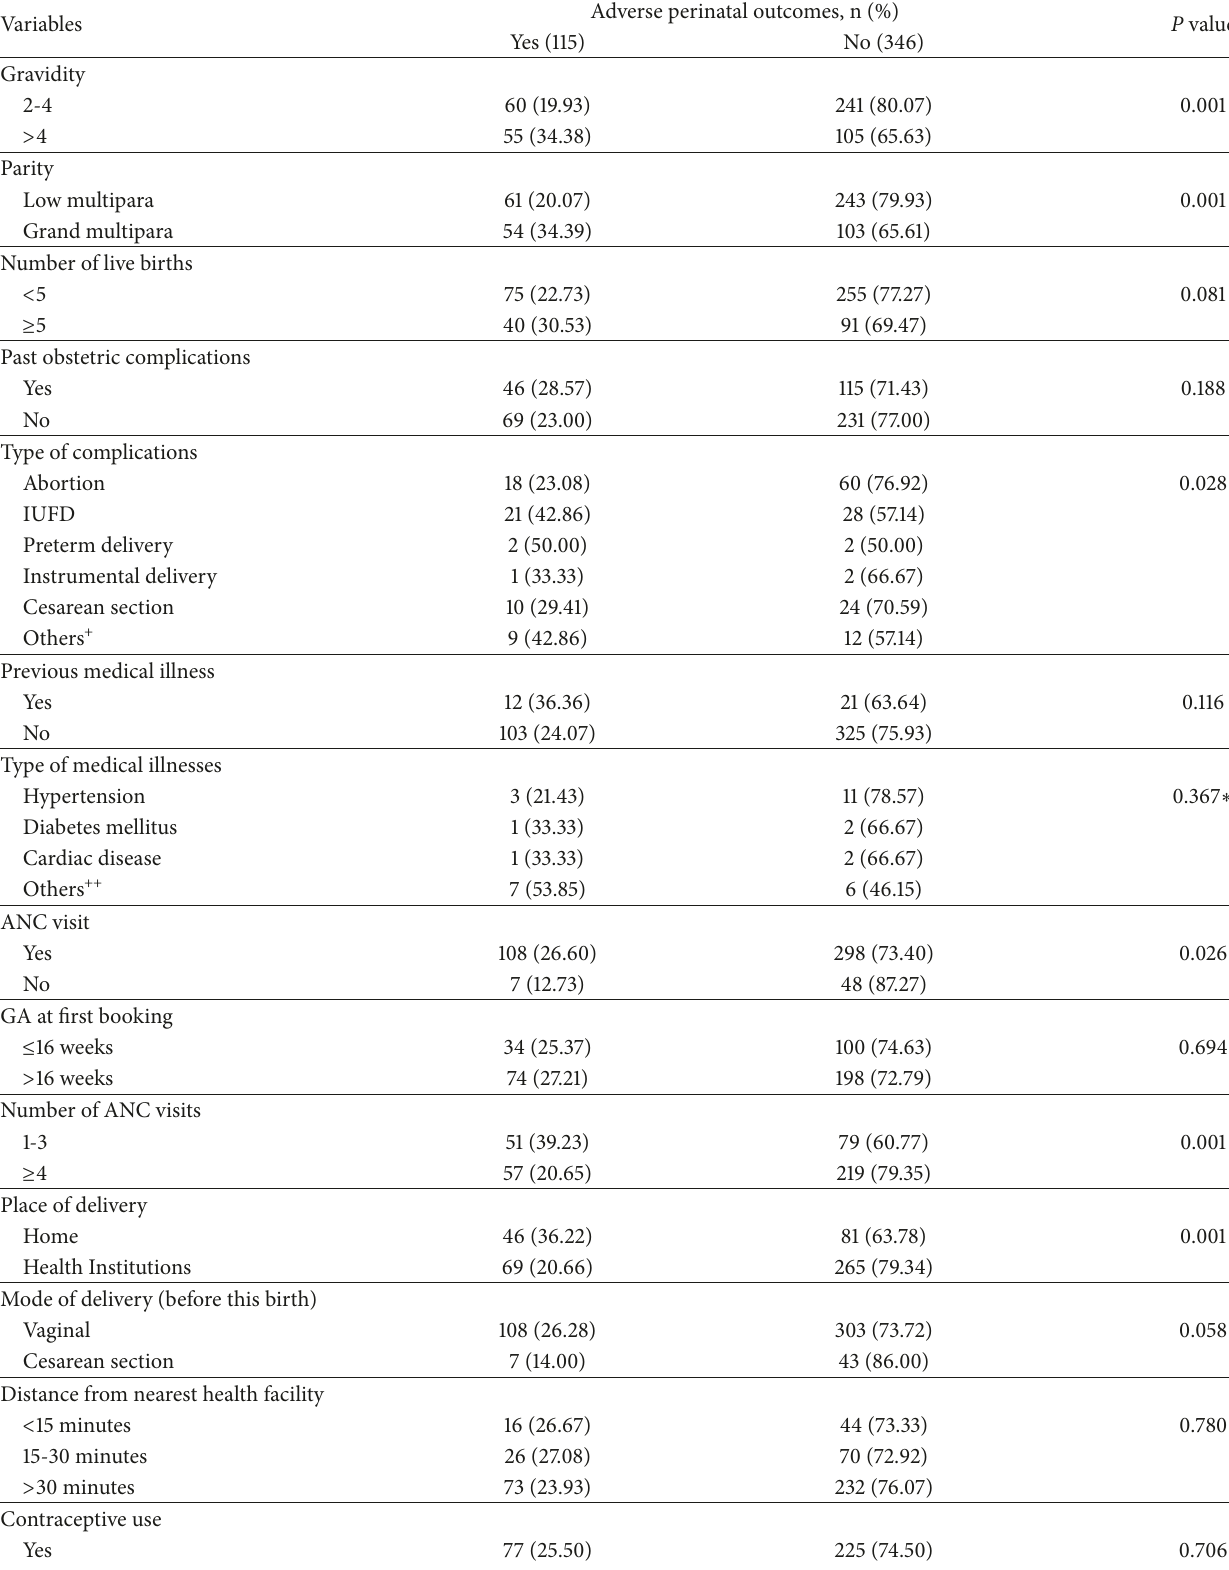
Table 2: Obstetric characteristics of respondents by perinatal outcomes in HUCSH & AGH, Southern Ethiopia, September 2018.